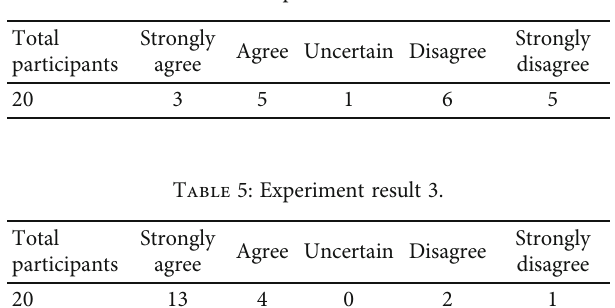
Table 4: Experiment result 2.